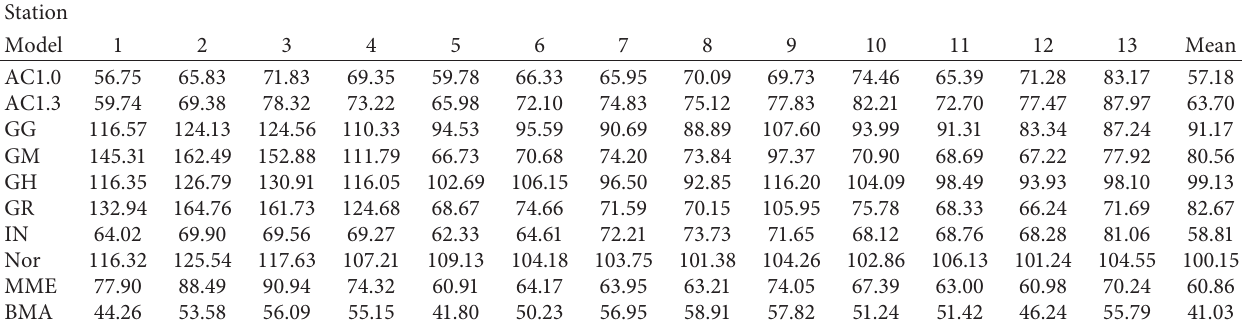
Table 6: The RMSE between the monthly observed precipitation and the simulation performance of individual GCMs, MME, and BMA simulation in the period of 1961–2005